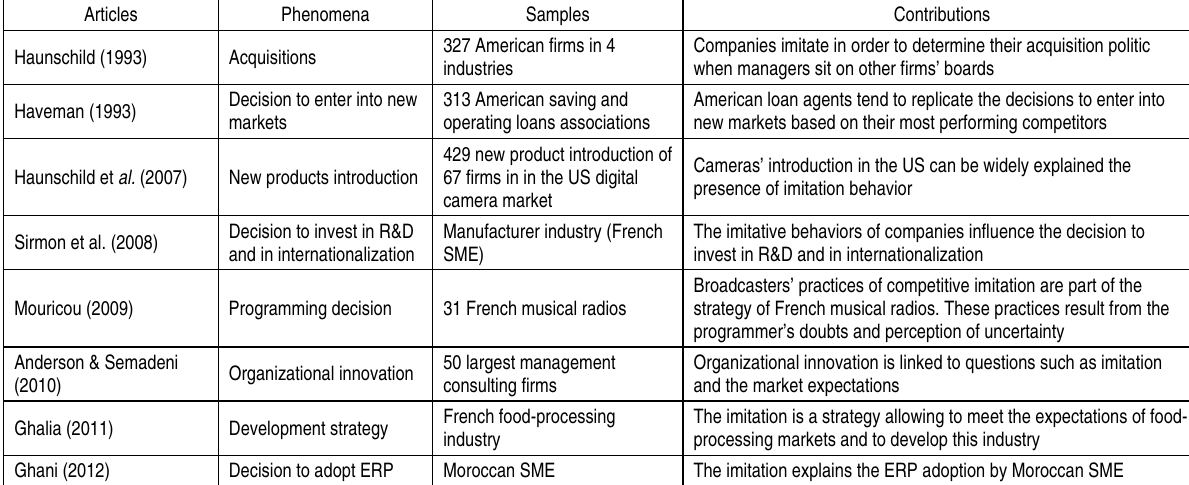
Table 1. The imitation and organizational of